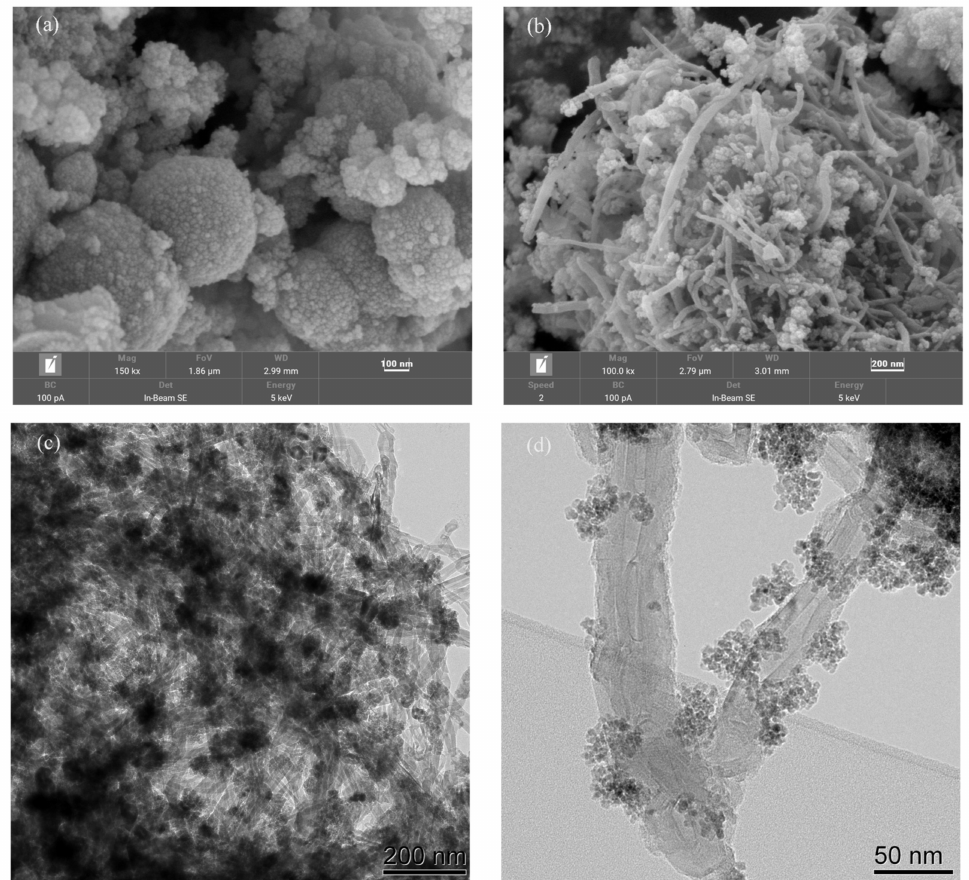
Figure 2. SEM images of ( a ) CoFe 2 O 4 , ( b ) CoFe 2 O 4 @CNTs, and ( c , d ) TEM images of CoFe 2 O 4